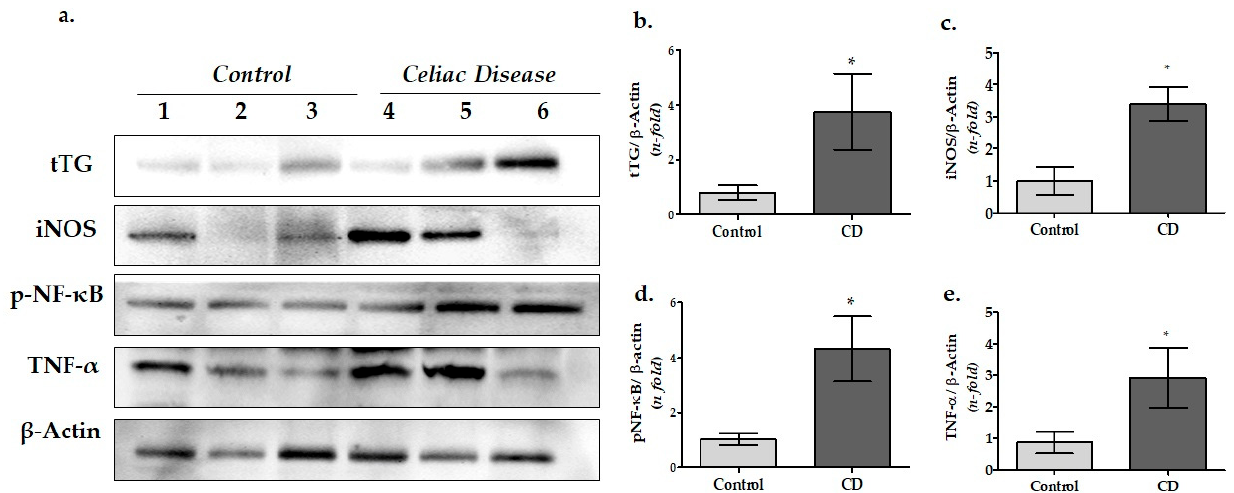
Figure 1. Protein expression levels of tTG and inflammatory proteins in the duodenal tissue of children with CD and the control group. ( a ) Protein expression of tTG, iNOS, p-NF- κ B, and TNF- α were determined by WB analysis and quantified by densitometric analysis. Relative densitometric values of the ( b ) tTG protein expression; ( c ) iNOS protein expression; ( d ) p-NF- κ B p65 protein expression; and ( e ) TNF- α protein expression levels. The β -actin signal was used to normalize the data, which were then expressed in arbitrary densitometric units. Data were expressed as mean ± SEM ( n = 3). * p < 0.05 versus the control group (CD: celiac disease group).